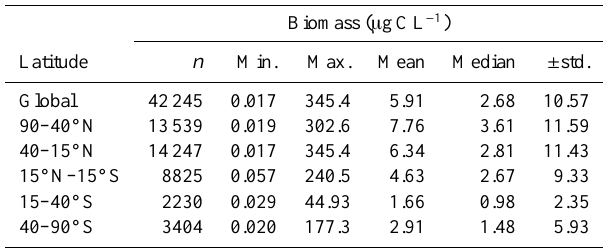
Table 5. Global and latitudinal band values for the gridded meso- zooplankton biomass